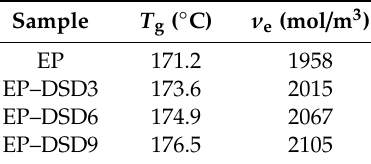
Table 5. Glass transition temperature ( T g ) and cross-linking degree values of neat EP and EP–DSD thermosets.